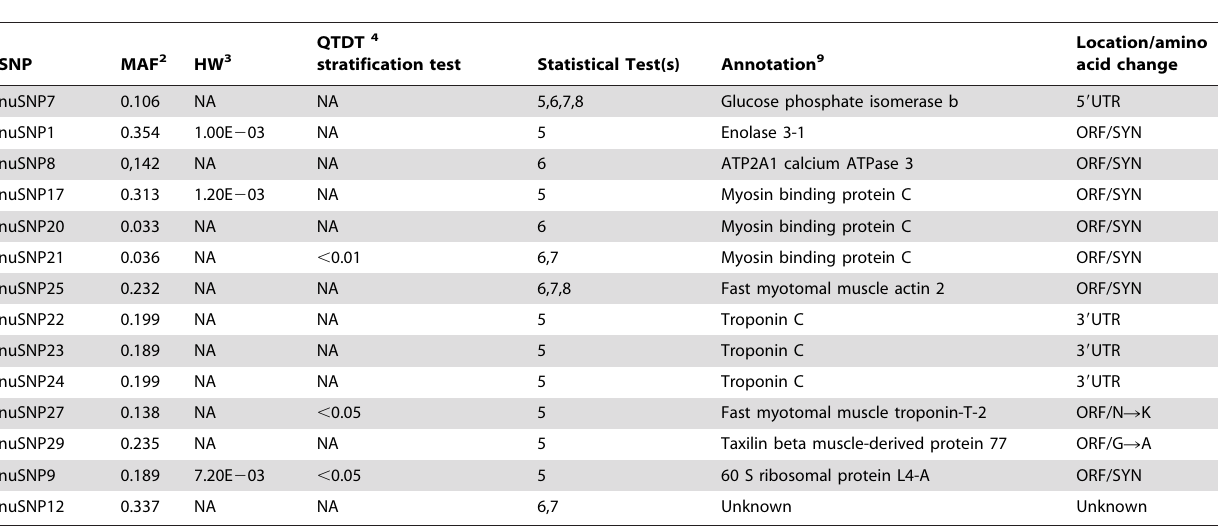
Location/amino acid change